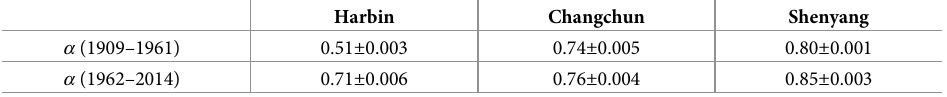
Table 1. The scaling exponent of the monthly mean temperatures at different time periods from 1909–2014 for the three